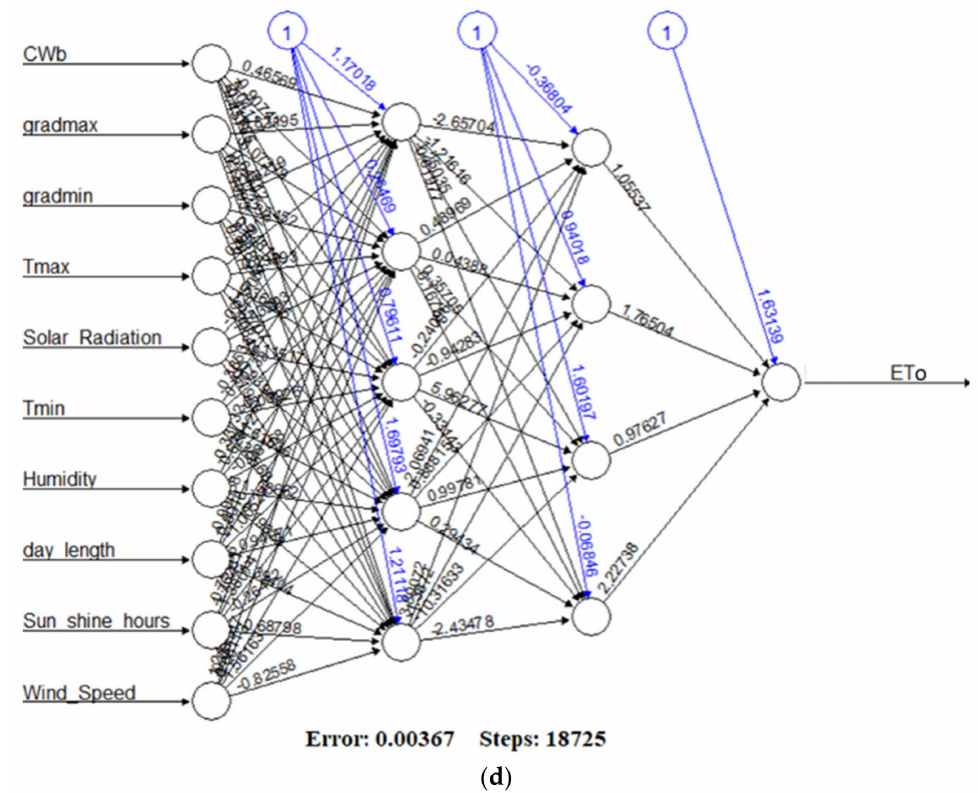
Figure 4. Neural network layouts for the optimal combined variables for predicting the ET o in Debrecen ( a ) Structural Network Design of the Superior Model—Hidden Layers (4, 3); ( b ) Structural Network Design of the Superior Model—Hidden Layers (6, 4); ( c ) Structural Network Design of the Superior Model—Hidden Layers (3, 2); ( d ) Structural Network Design of the Superior Model — Hidden Layers (5,